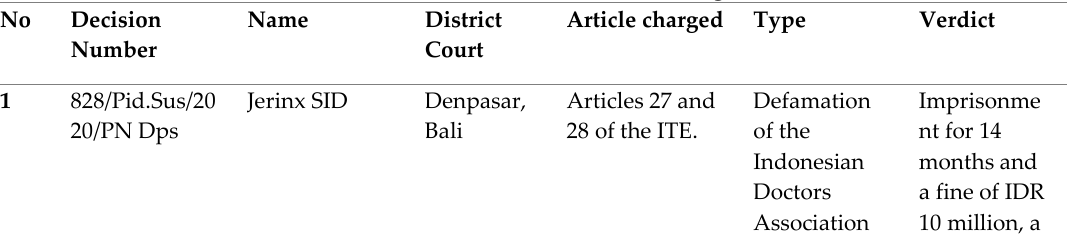
Cases of Criminal Offenses Against